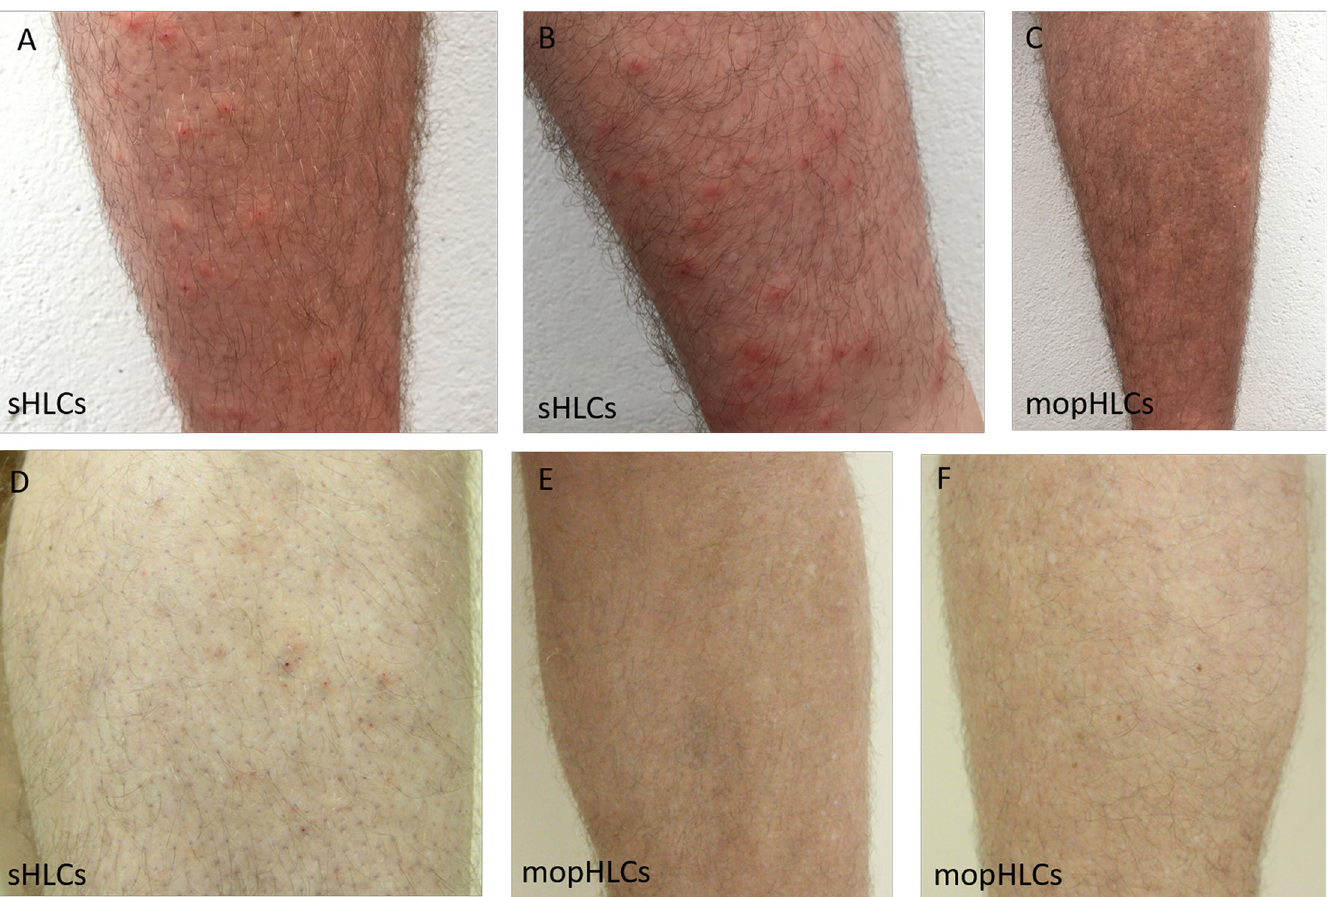
Fig 1. Shows close-up photographs of the legs of vector collector JLC, taken on the 28th of October 2017 (panels A to C) and the 30th of October 2017 (panels D to F). Panels A, B and D are photographs of JLC´s right leg, which was exclusively used for sHLC trapping; panels C, E and F are of JLC´s left leg, which was used exclusively for mopHLC trapping. In panels A, B and D simuliid bite marks can be identified by their distinctive deep-red pin-head-sized scab mark, which are formed from the wound simuliids create to pool-feed [23]. Many of the bite marks shown in panels A and B can be seen to be ringed by a pinkish (and slightly raised) disc of skin about 5 mm in diameter. While some of the bite marks visible in panel D are also ringed by pinkish skin, the bite marks are less